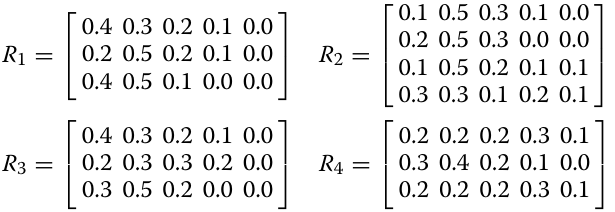
Table 5 Key indicator evaluation table of new competitive advantages of China’s export in 2016 Judge